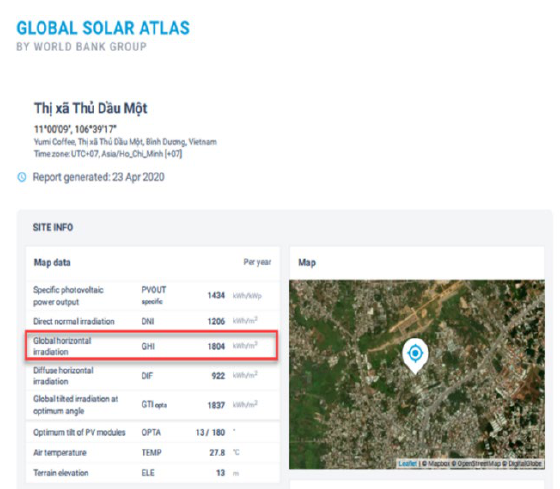
Figure 3. Site information and solar radiation [6].